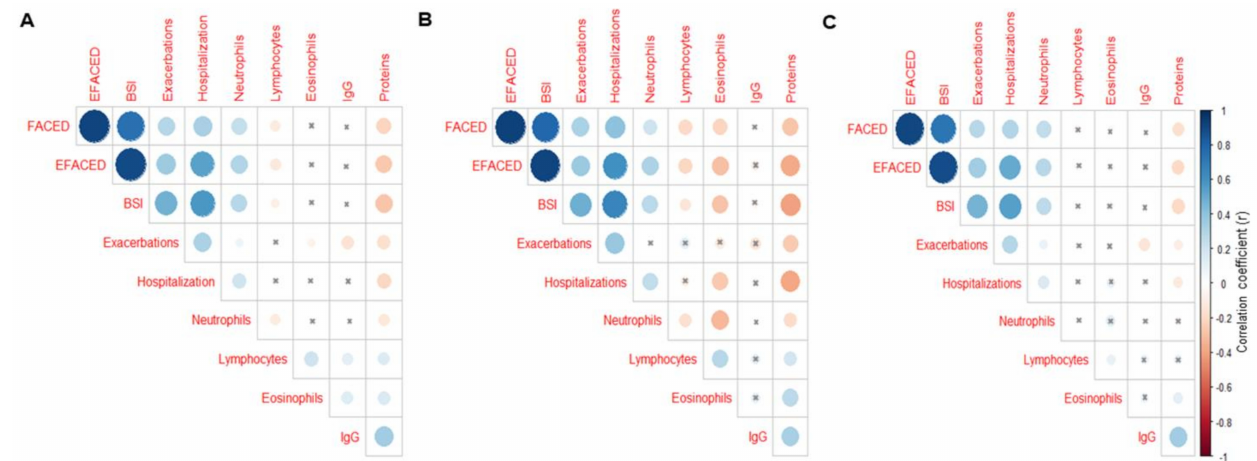
Figure 3. Histograms of the proportions of patients who were classified as mild–moderate–severe according to EFACED ( A ), BSI ( B ), and FACED ( C ) between the two clusters. EFACED: mild: 0–3, moderate: 4–6, and severe: 7–9; BSI: mild: 0–4, moderate: 5–8, and severe: ≥ 9; and FACED: mild: 0–2, moderate: 3 to 4, and severe: 5–7. Statistical significance: **, p < 0.01 between the patient groups.